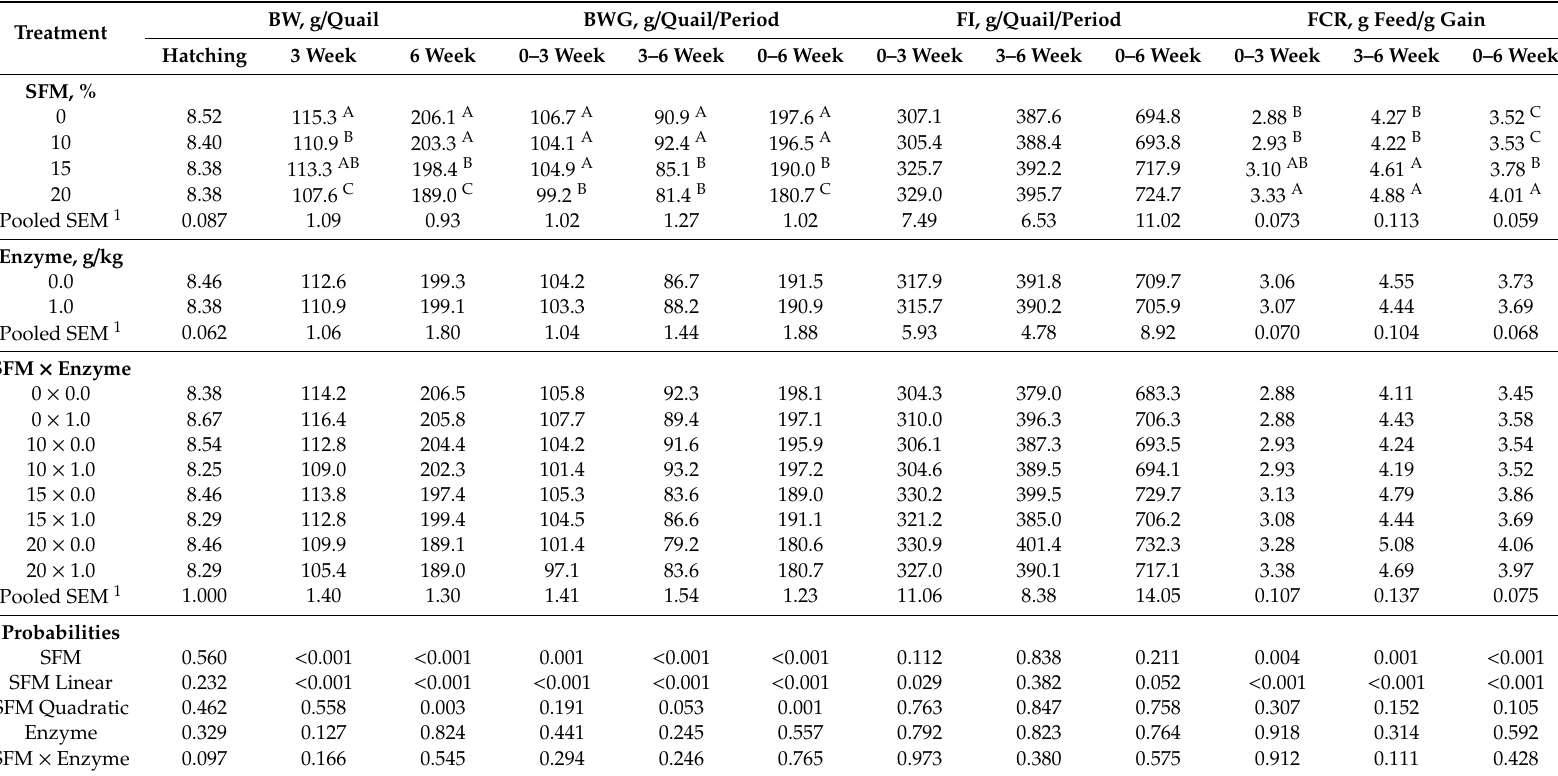
Table 2. Influence of sunflower meal (SFM) and multi-enzyme supplementation in diet on the performance parameters in growing quails *.